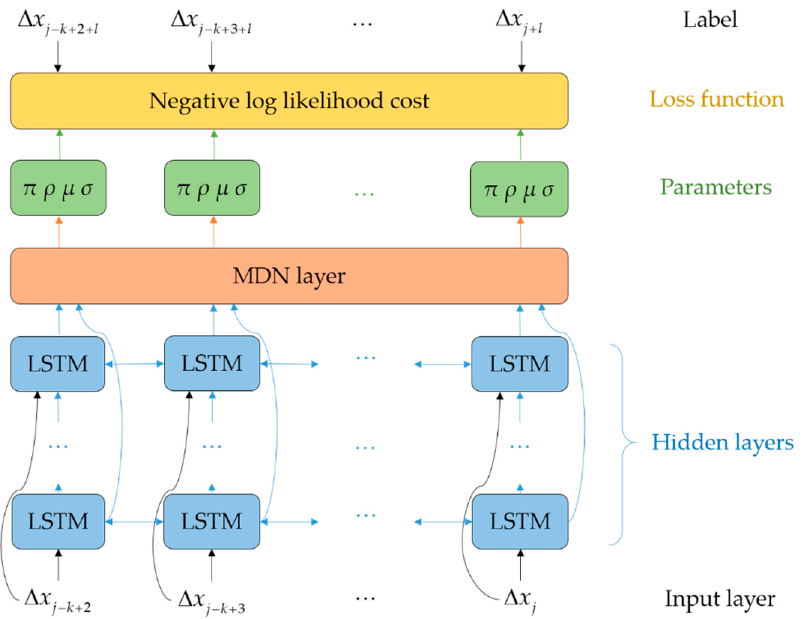
Figure 3. Schematic of unfolded structure of bidirectional recurrent mixture density network (BiRMDN). LSTM: long-short term memory, MDN: mixture density network.